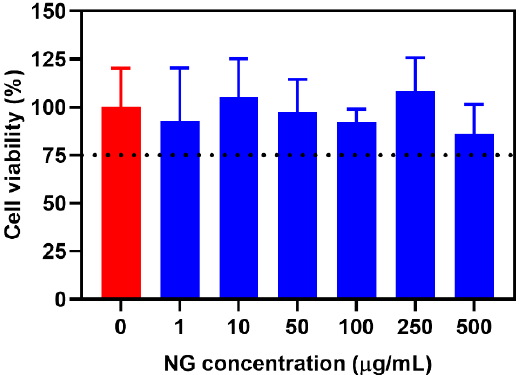
Figure 7. Cytotoxicity profile of bare NG in HCT 116 colon cancer cell line at different NG concentrations (0, 1, 10, 50, 100, 250, and 500 µg/mL) after 24 h of incubation at 37 °C. Data are presented as the mean ± SD (n = 4).